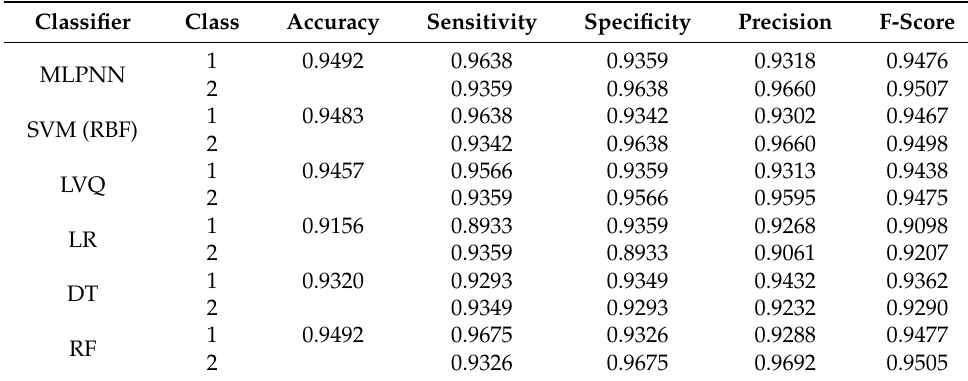
Table 3. Classification results for NSGA II selected sets of